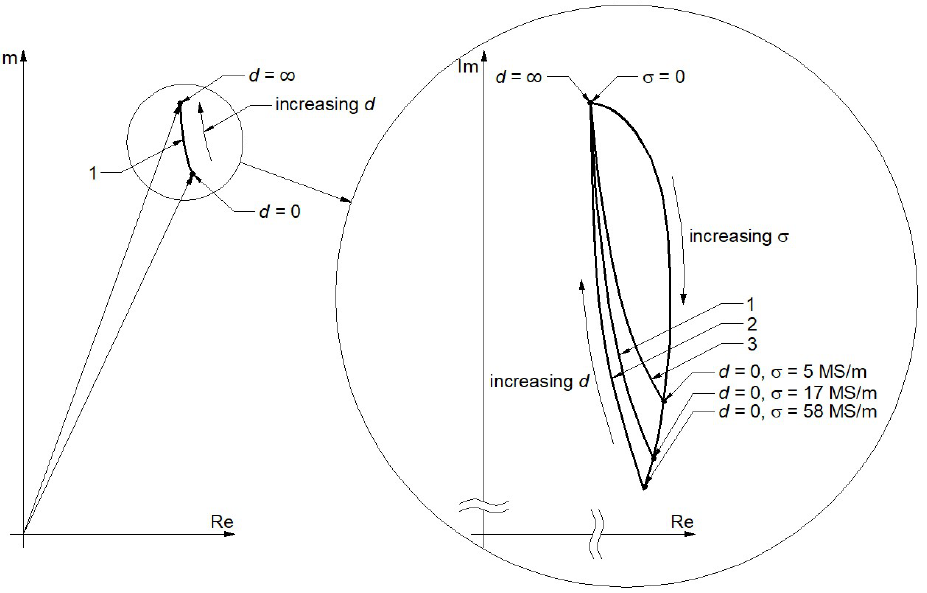
Figure 3. Dependence of the coil impedance of the parametric ECP on the thickness of coating and specific electrical conductivity.